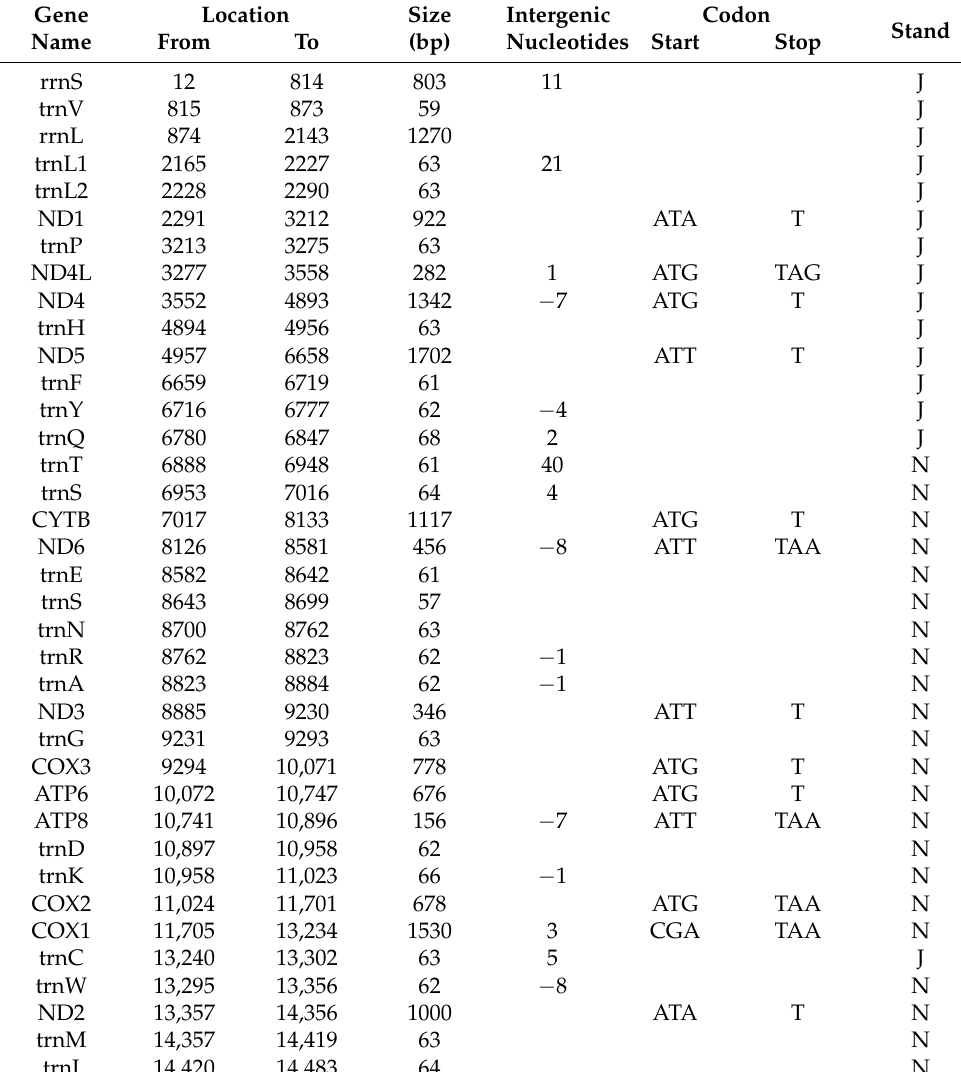
Table 2. Mitogenomic organization of S. bungii .